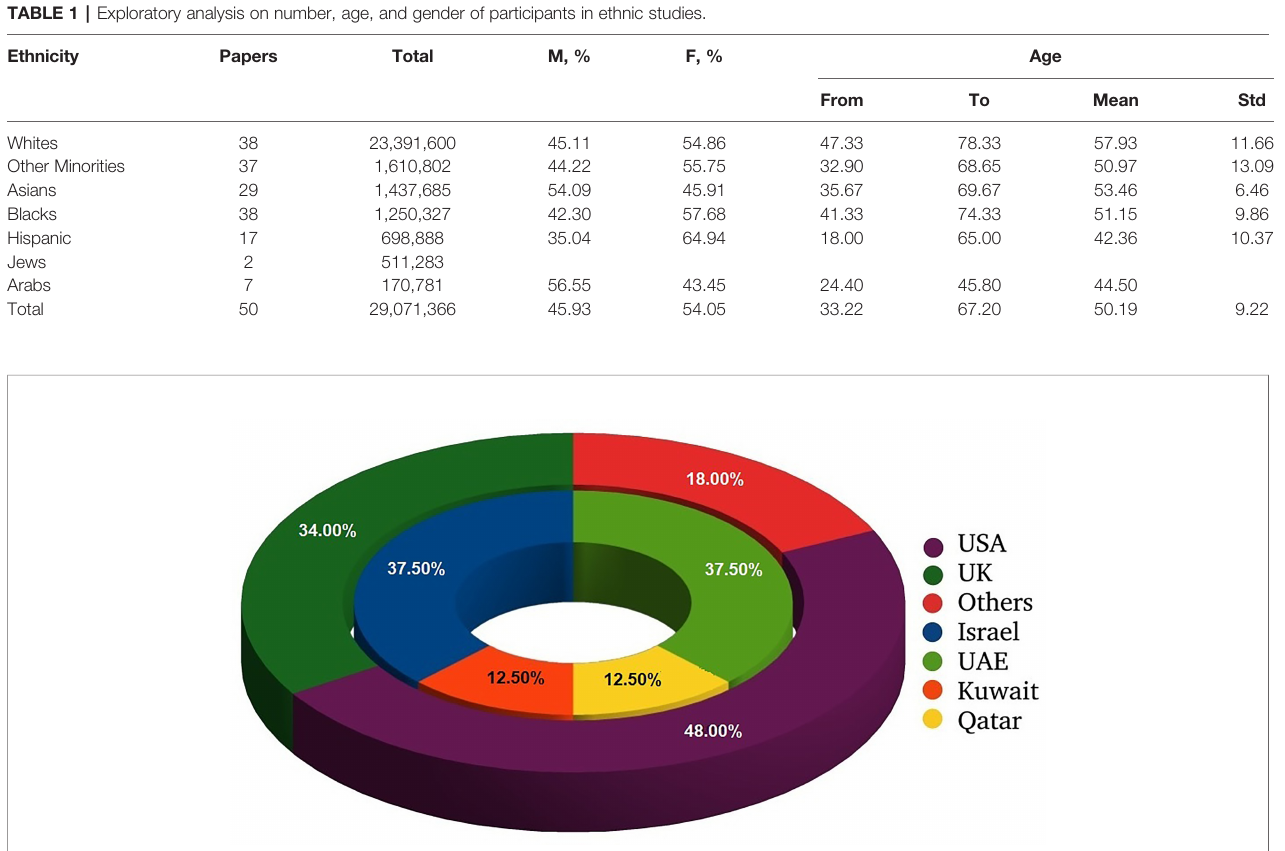
FIGURE 1 | Distribution of research papers on ethnical issues of COVID-19 with regard to location of study. External circle presents all analyzed studies; internal one shows information on studies conducted in Middle East.